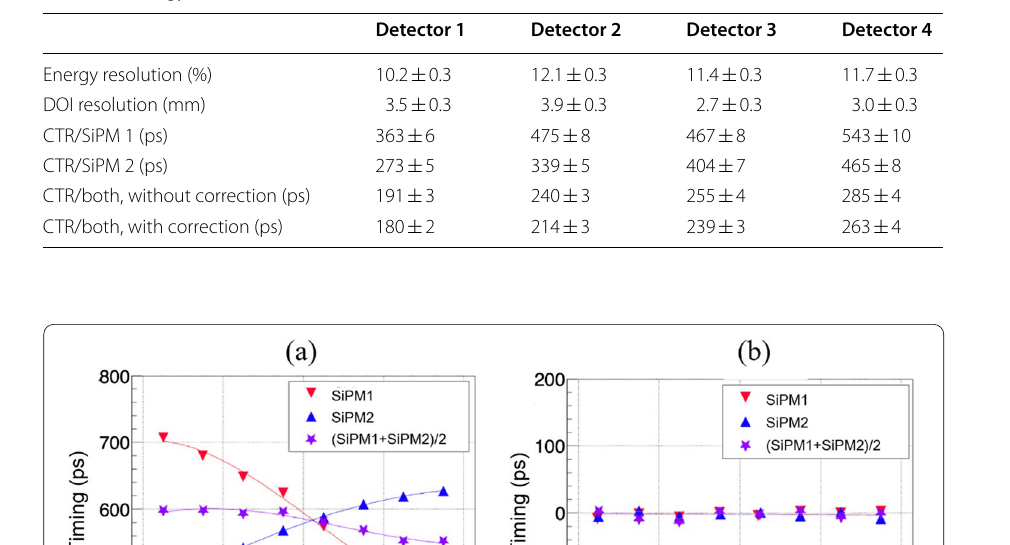
Table 2 Energy resolution, DOI resolution and CTRs of the four detectors